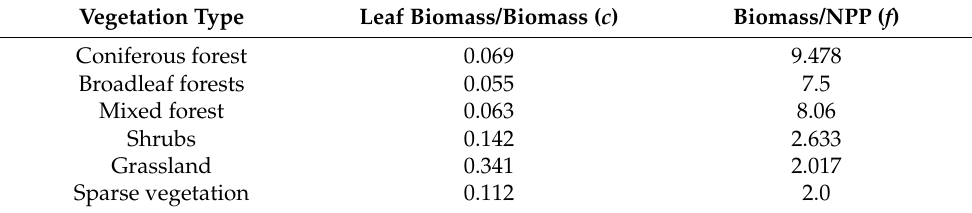
Table 2. Conversion factors between leaf biomass and biomass and biomass and NPP for different vegetation types in